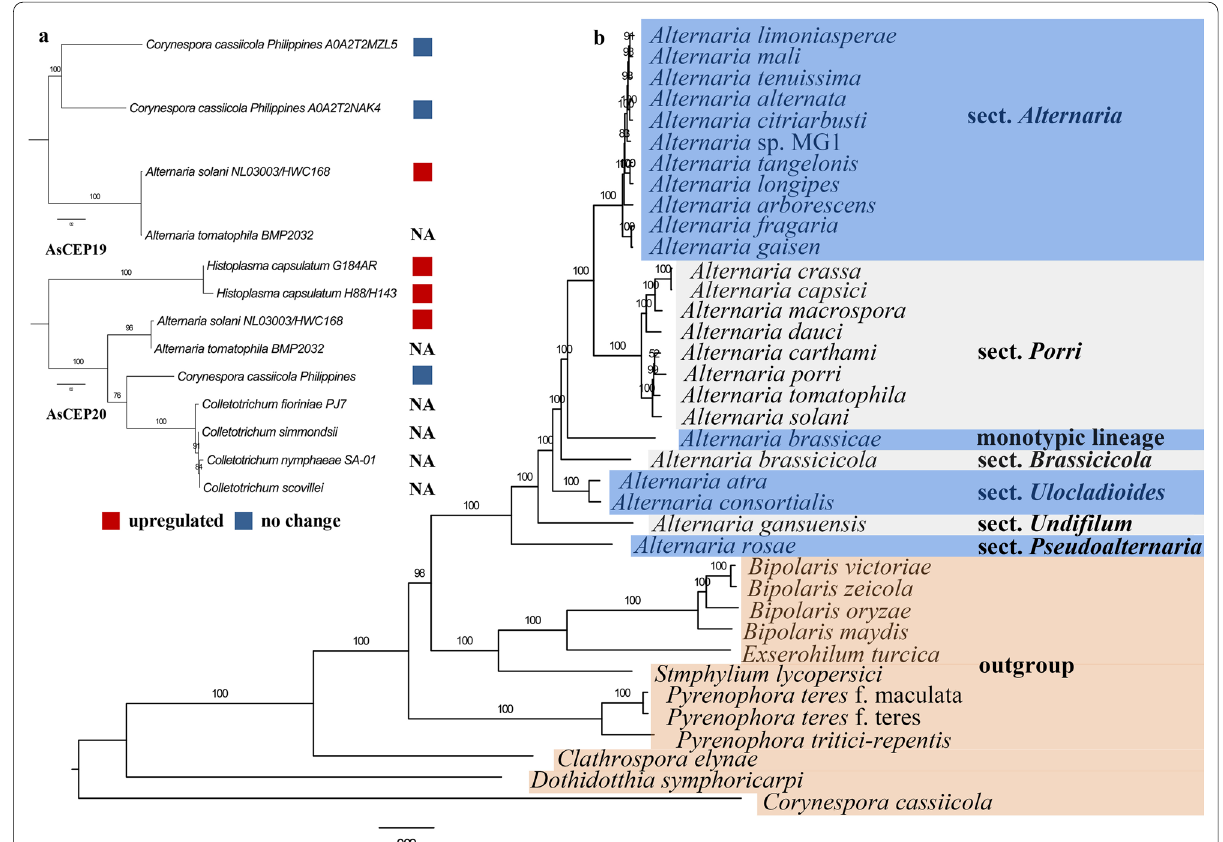
Fig. 4 Gene trees of AsCEP19 and AsCEP20 and species tree of the genus Alternaria . The best amino acid substitute models were determined using ProtTest. Maximum-likelihood trees were constructed using RAxML. a Phylogenetic trees constructed according to amino acid sequences of AsCEP19, AsCEP20 and their homologous proteins. The numbers shown next to the branches indicate the percentage of bootstrap support values (1000 replicates). The branch lengths indicate the evolutionary distance as the number of base substitutions per site. The rectangular boxes represent the changes in the gene expression during fungal infection. NA, data not available; b Phylogenetic tree constructed according to the alignments of 1,216 single-cpoy protein-coding genes from 37 fungal genome datasets. The 1,216 orthogroups were aligned using MAFFT, and these multiple alignments were trimmed and concatenated into a